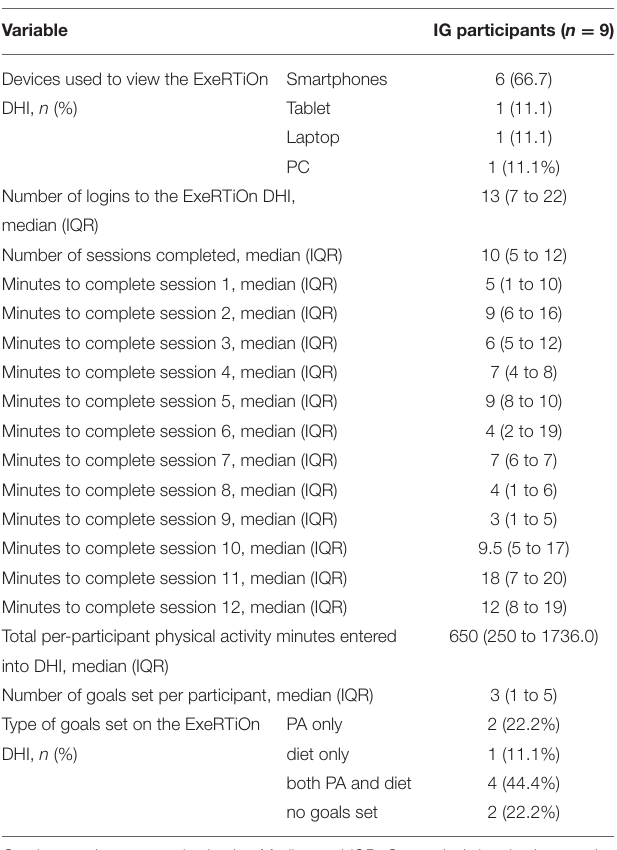
TABLE 3 | Intervention group participants engagement with the ExeRTiOn